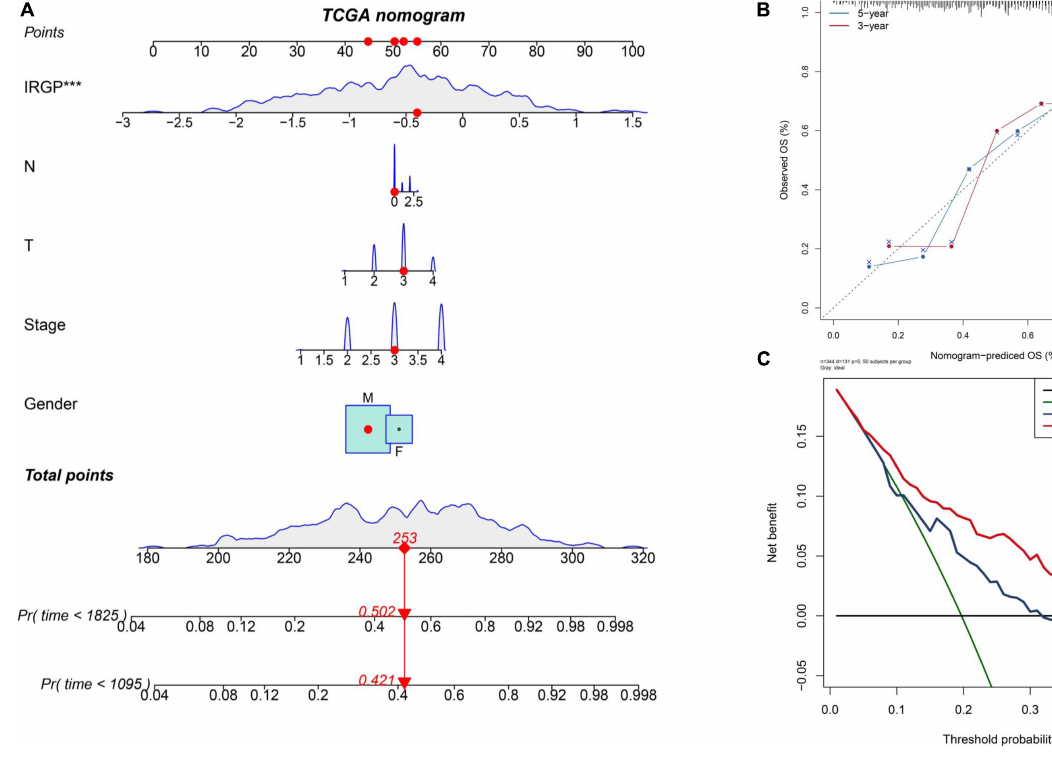
FIGURE 4 | Construct and evaluate nomograms in TCGA-BLCA cohort. (A) Nomograms for predicting the probability of patient mortality based on IRPG signature and clinical variables. (B) The calibration plot for internal validation of the nomogram. (C) Decision curve analyses of the nomograms based on IRGP signature for 3-year overall survival. BLCA, bladder cancer; IRGP, immune-related gene